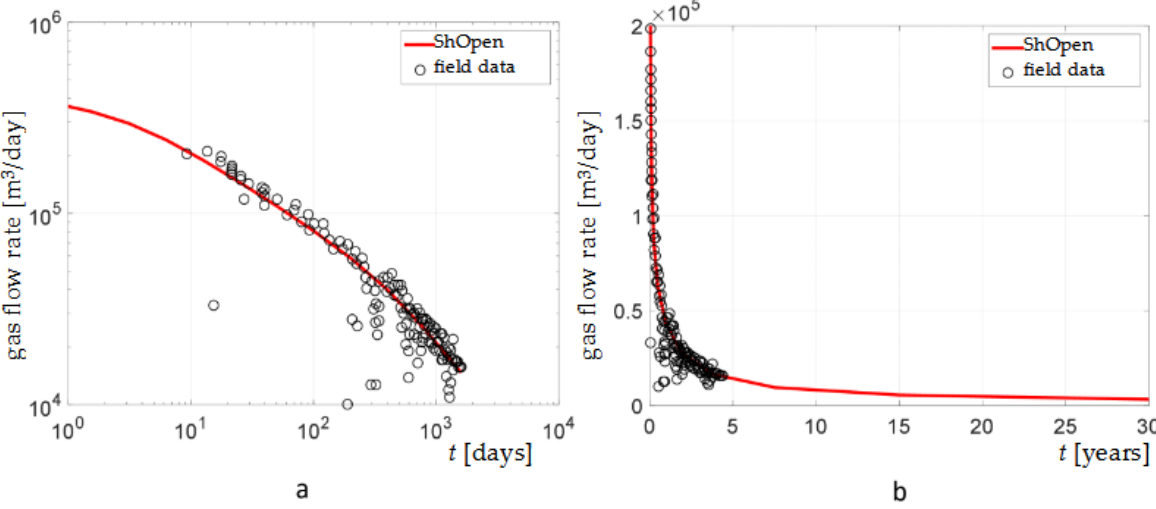
Figure 21. History matching ( a ) and prediction ( b ) of the gas production rate in the Barnett shale reservoir (simulation AE1).